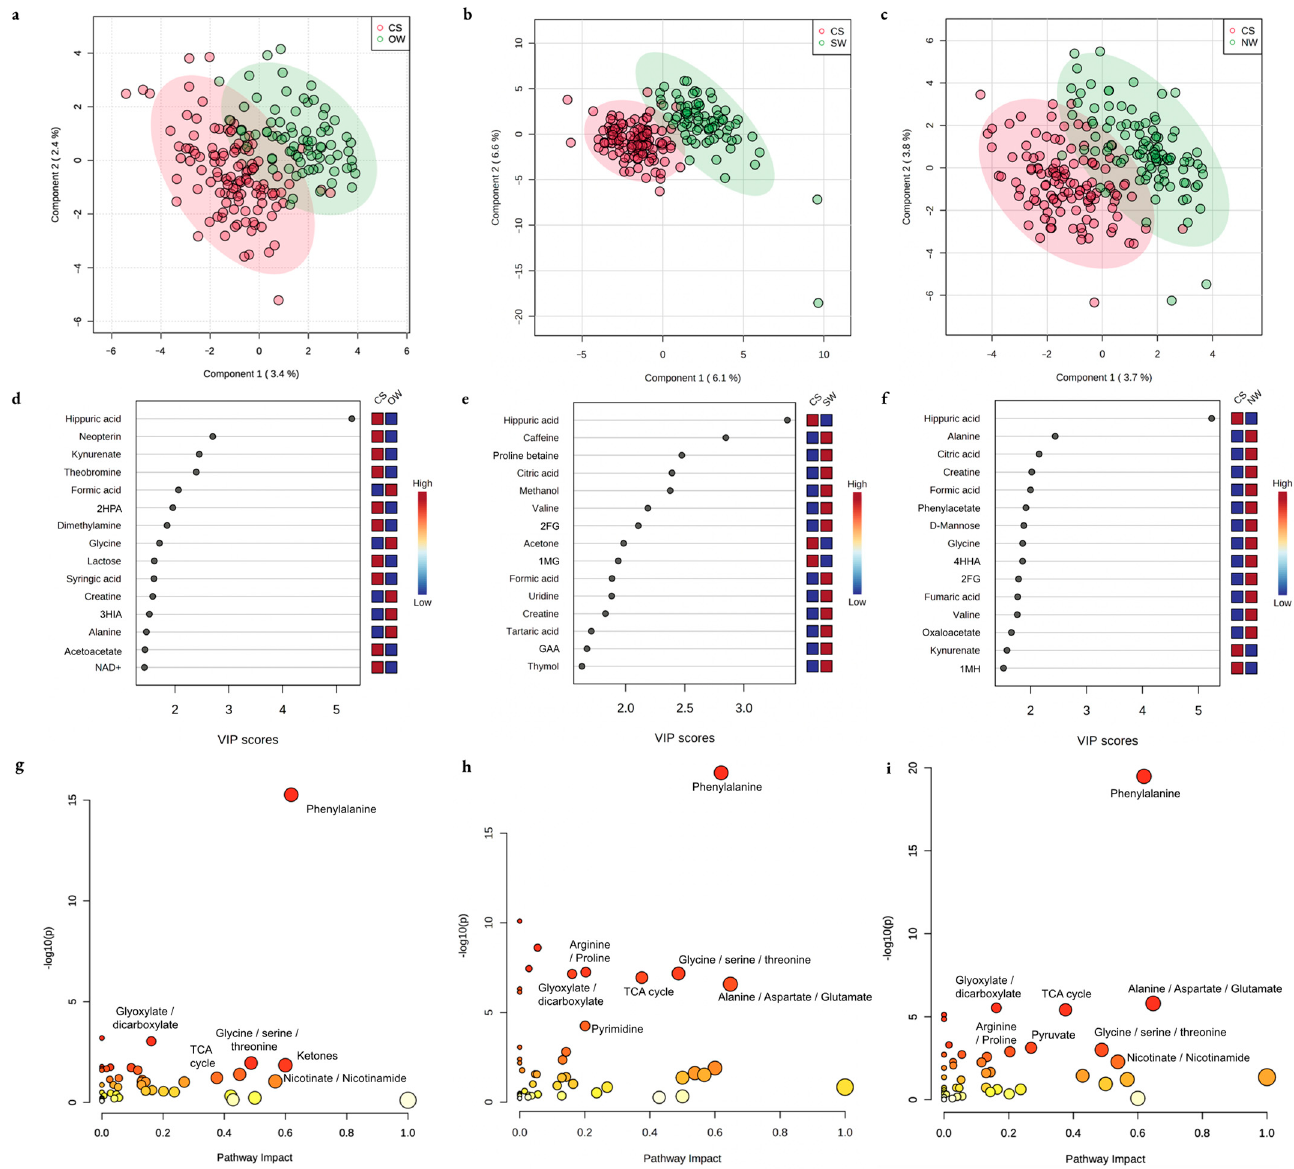
Figure 2. Differential metabolic features of urine between comparison groups using partial least squares discriminant analysis (PLS-DA). Two-dimensional visualization of the separation of groups by PLS-DA is shown in Nicaraguan cane harvest and seed cutters (CS) compared with ( a ) other cane workers (OW) in Nicaragua, ( b ) Spain agricultural workers (SW), and ( c ) non-agricultural workers (NW) in Nicaragua. Important features by variable importance in prognosis (VIP) score in PLS-DA are shown in the CS group compared to the ( d ) OW, ( e ) SW, and ( f ) NW groups. Significant metabolic pathways differentiating groups are shown in the CS group compared to the ( g ) OW, ( h ) SW, and ( i ) NW groups. 2HPA, 2-hydroxyphenylacetic acid; 3HIA, 3-hydroxyisovaleric acid; NAD+,